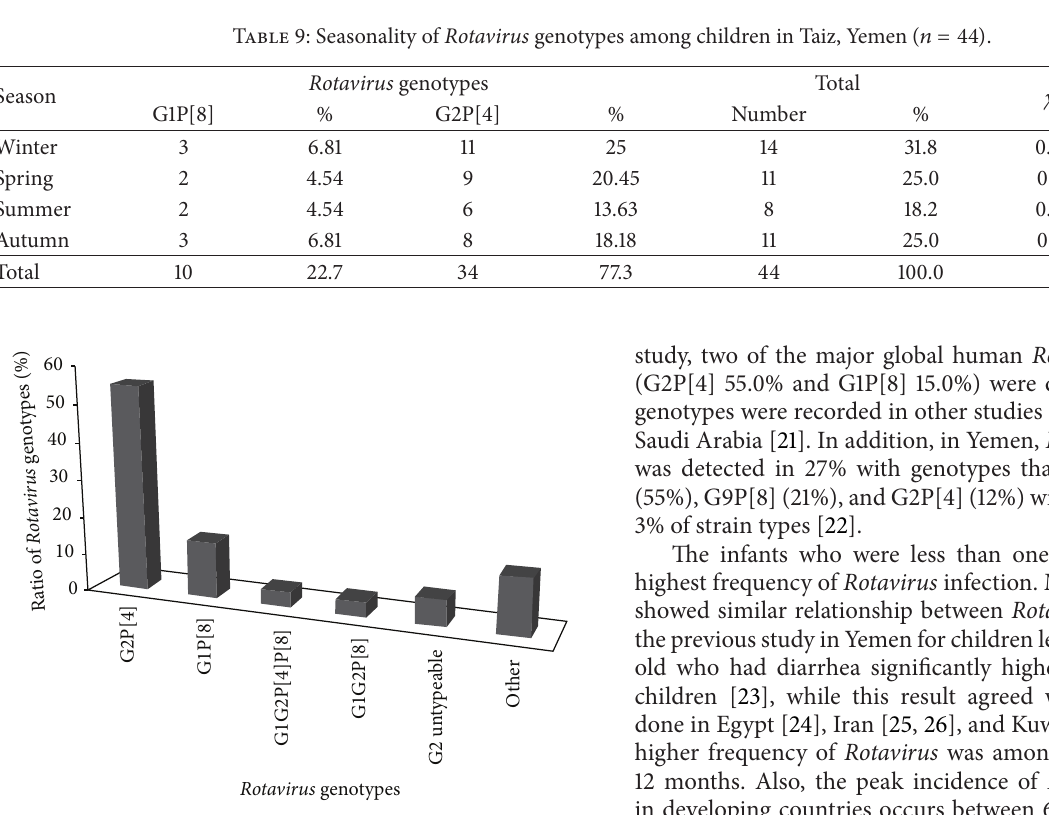
Figure 2: Common genotypes of Rotavirus diarrhea among chil- dren in Taiz,